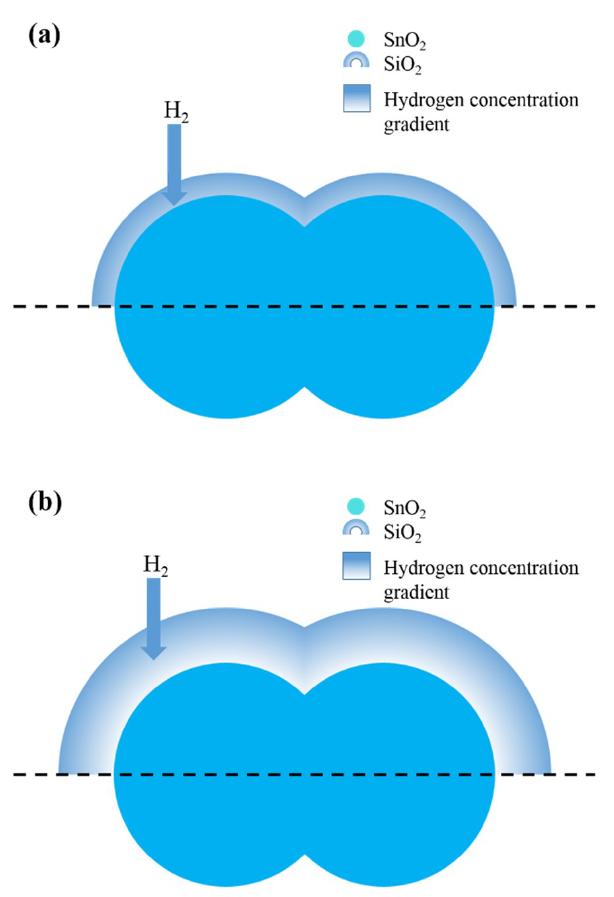
Figure 14. Schematic diagram showing the mechanism underlying gas sensing using SnO 2 sensors with ( a ) thin SiO 2 layer and ( b ) thick SiO 2 layer deposited on their surfaces.